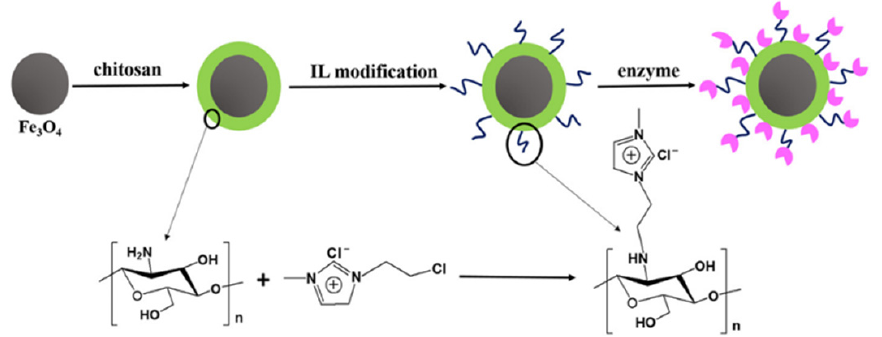
Figure 9. Synthetic scheme of IL-CS-Fe 3 O 4 and its application in PPL immobilization. Reproduced with permission from [85] , Elsevier, 2019.